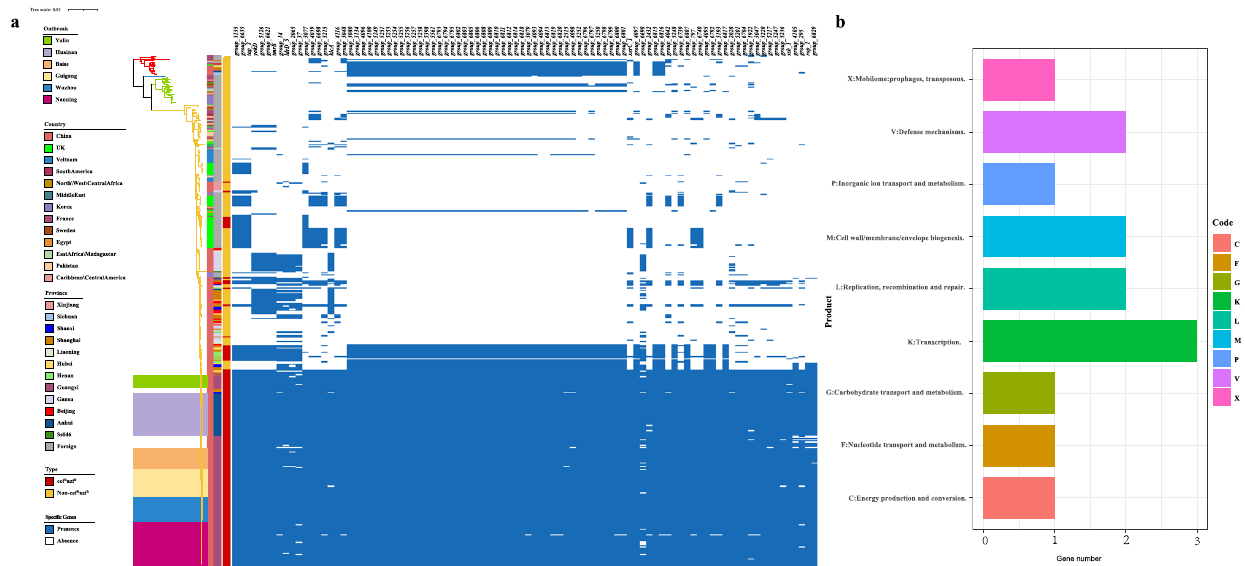
Fig. 6 | Accessory genes identi fi ed by pangenome analysis that might be associatedwithcef R azi R isolatesandtheoutbreakstrains.a showstheaccessory genes signi fi cantly associated with the cef R azi R phenotype. There were 92 genes screenedbythechi-squaretestwhose P valueswerelowerthan1e-30andde fi nedas genesiftheirproportionwasmorethan80%inthecef R azi R